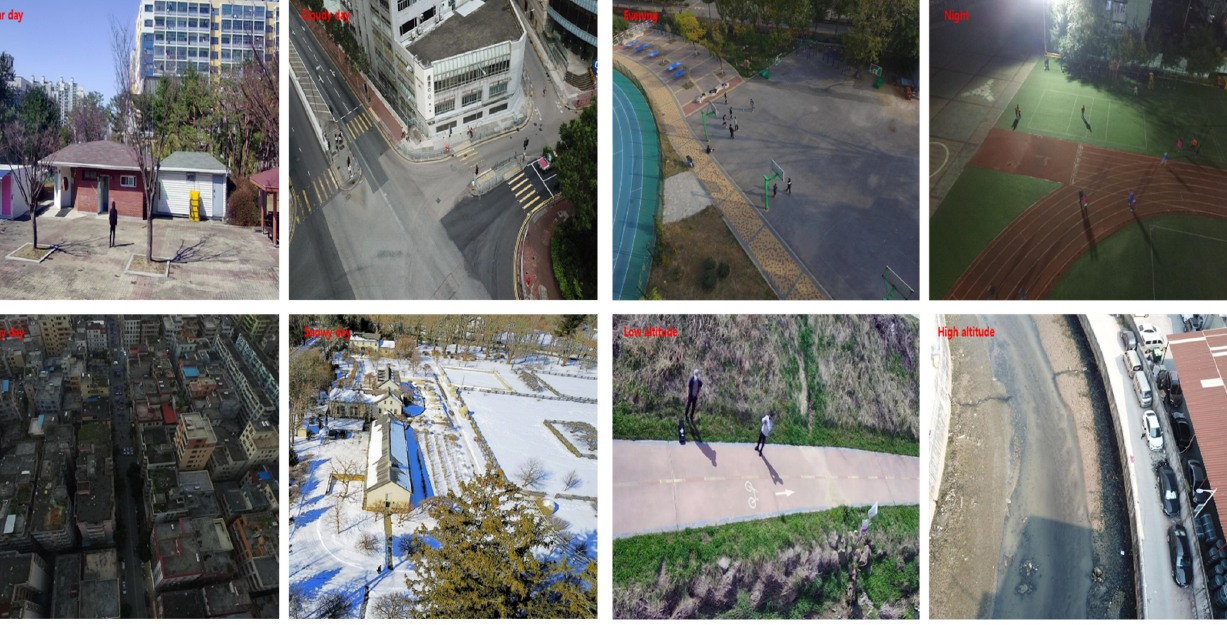
Figure 8. Images of various experimental conditions captured by drone.